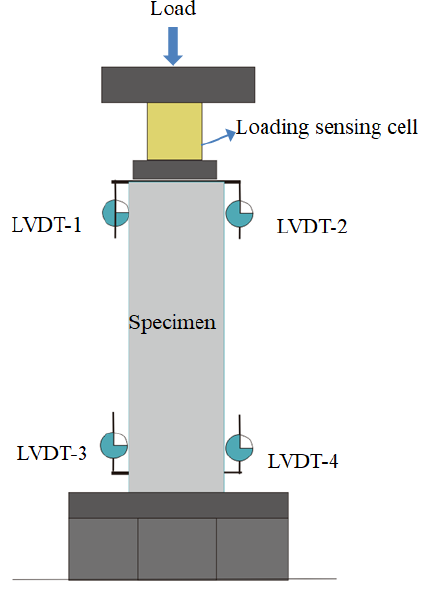
Figure 5. Electronic universal testing machine.